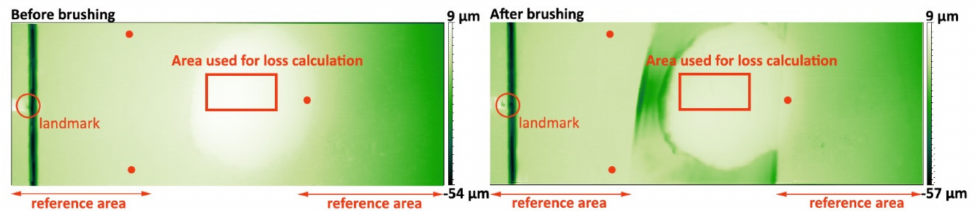
Figure 3. Profilometer height map of embedded enamel sample before and after brushing (exemplar- ily). The red dots indicate the points used for a plane-level correction. The cut marks in the reference area were used as landmarks for a slight x/y shift (see Section 2.3).